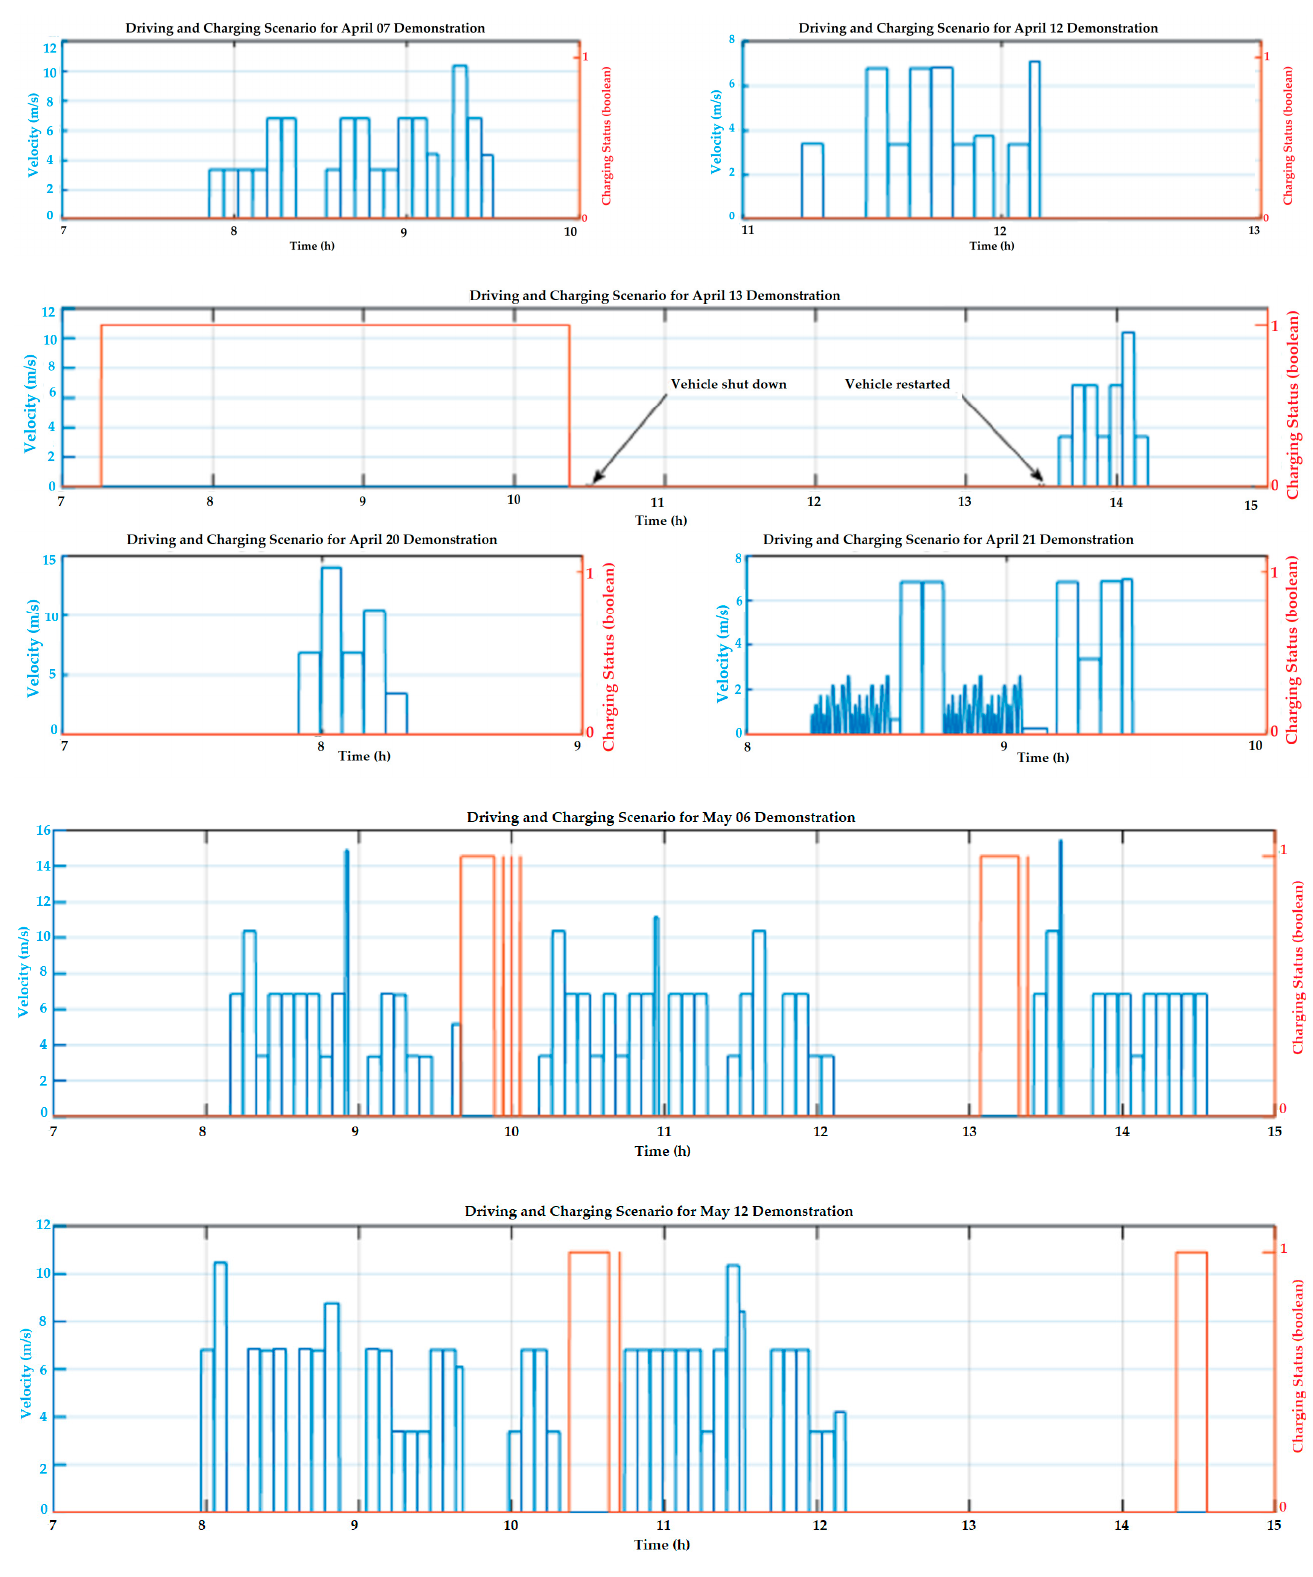
Figure 7. Osnabruck driving scenarios during the 18 m electric bus demonstrations.